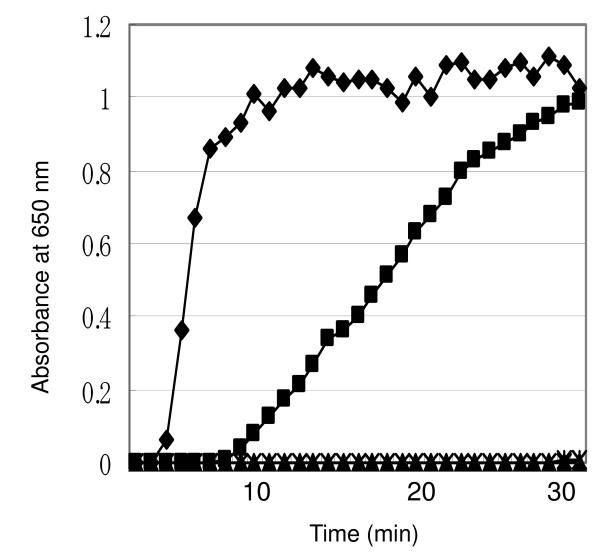
Thioredoxin-catalyzed reduction of insulin by DTT. Increase in turbidity at 650 nm was plotted against reaction time. Closed diamond, rHBP35(Q22-P344) plus DTT; closed square, E. coli thioredoxin plus DTT; closed triangle, rHBP35(Q22-P344 with C48S C51S) plus DTT; X, rHBP35(Q22-P344) without DTT.